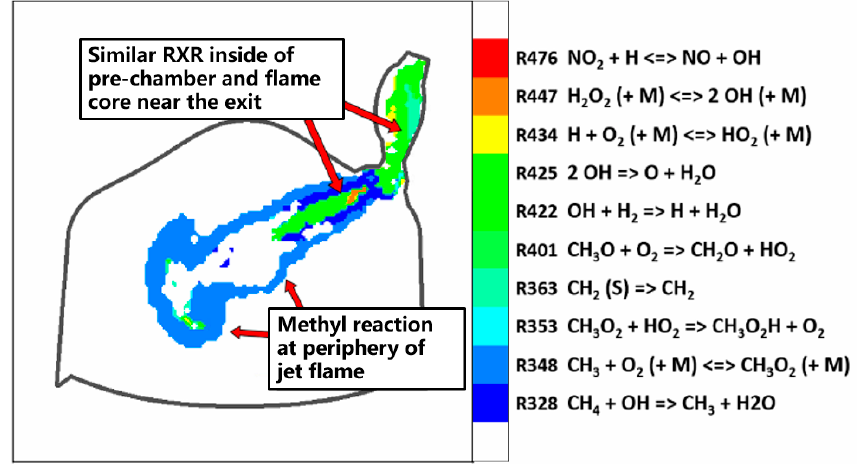
Figure 12. RXR distribution at 353.8 °CA, and the clip plane is along the jet direction axis and vertical direction.